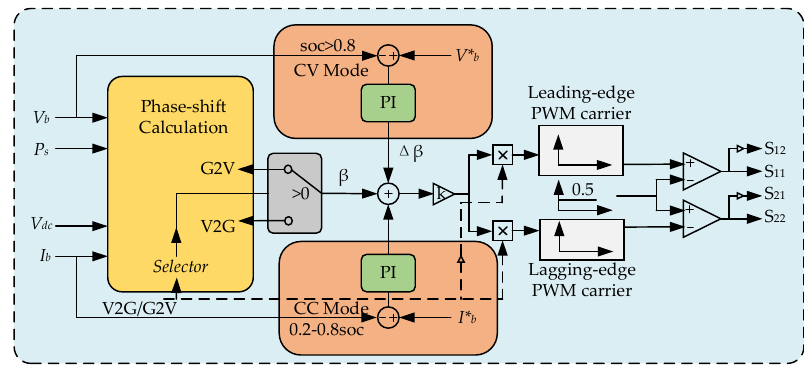
Figure 19. DAB phase shift algorithm.